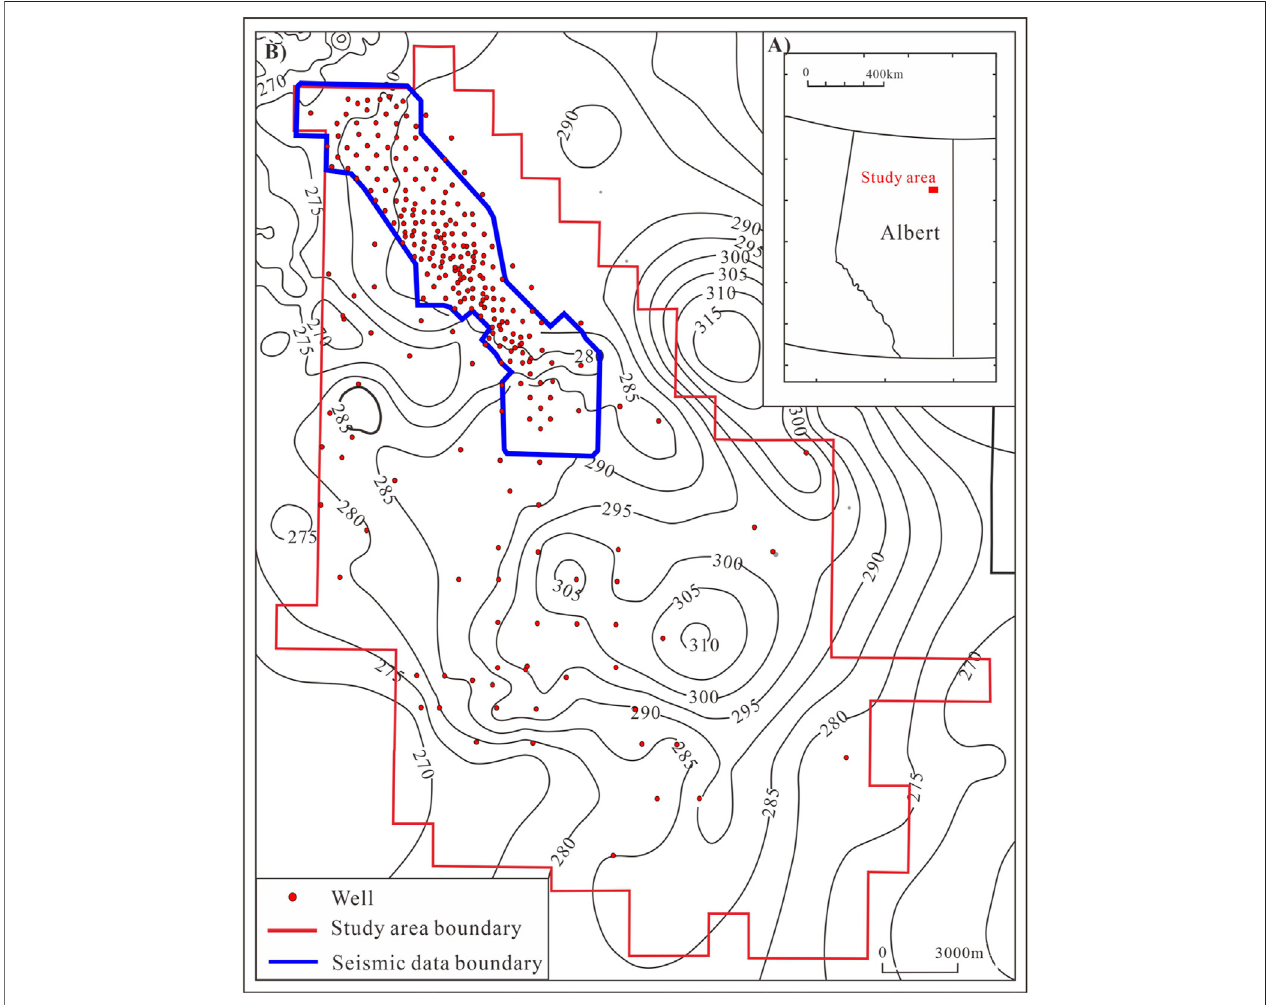
FIGURE 1 | (A) Location map of the study area; (B) The study area regional paleozoic structure map. The seismic data is located in dense well pattern area.